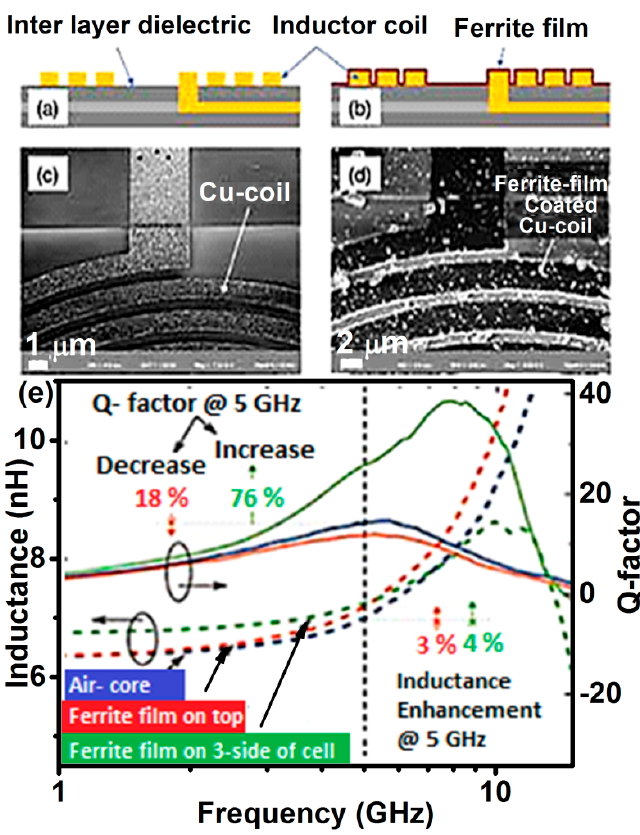
Figure 12. Schematic of inductor coil on a Si-CMOS chip ( a ) with passivation removed from 3-sides of the coil, and ( b ) with ZnFe 2 O 4 thin (250 nm) film-coated conformally; ( c , d ) show the SEM images of the coil before and after ferrite coating; ( e ) Measured inductance and Q-factor of the on-chip inductance with ferrite film deposited only on top (in red) and surrounding 3-sides of the coil (in green) (Reproduced with permission from [55]. Electrochemical Society, 2017).